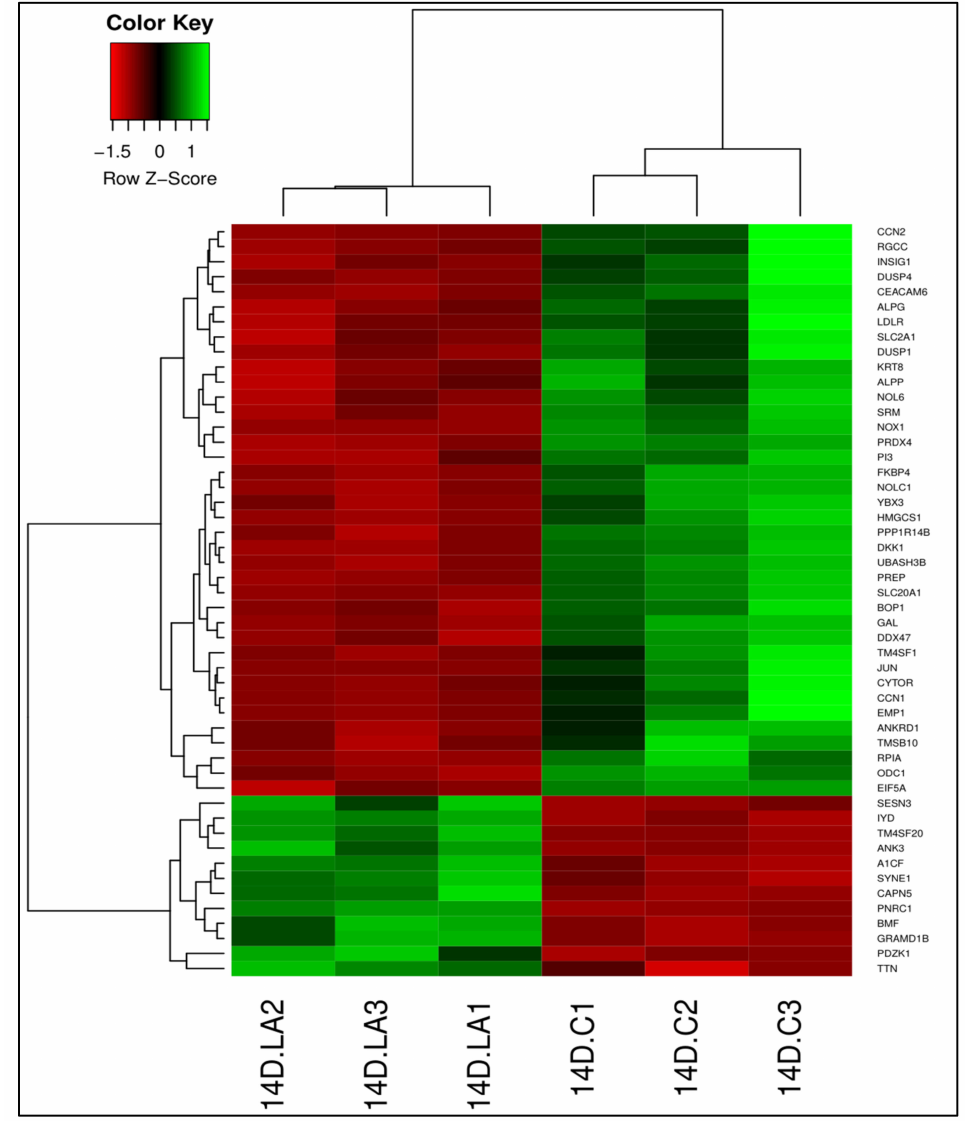
Figure 3. Differential gene expression between linoleic acid (LA)-treated cells and untreated control cells. Heatmap shows the top 50 DEGs (adjusted p < 0.05) in LA-treated Caco-2 cells (14D.LA1, 14D.LA2, and 14D.LA3) compared to untreated cells (14D.C1, 14D.C2, and 14D.C3). Green, upregu- lated; red,